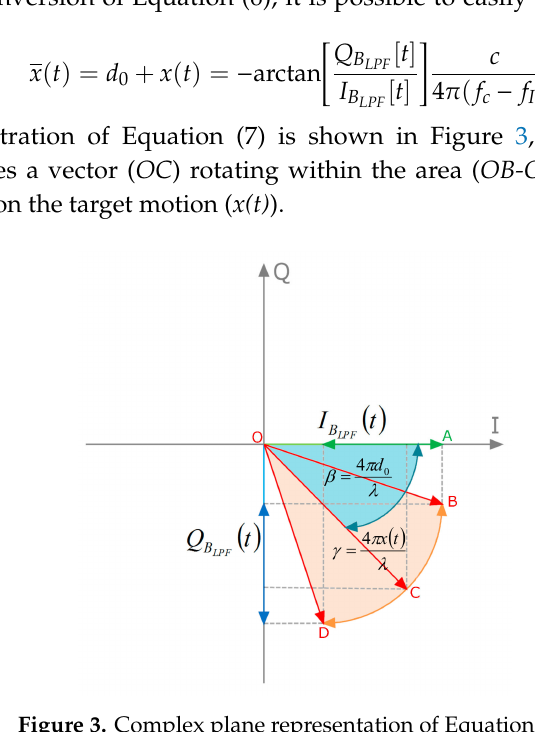
Figure 3. Complex plane representation of Equation (7).